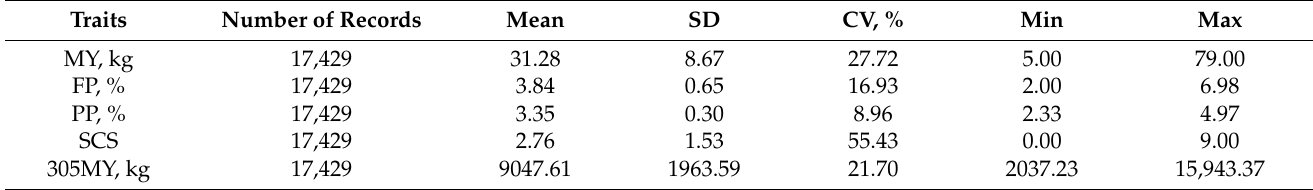
Table 3. Descriptive statistics for milk production traits in Chinese Holsteins 1